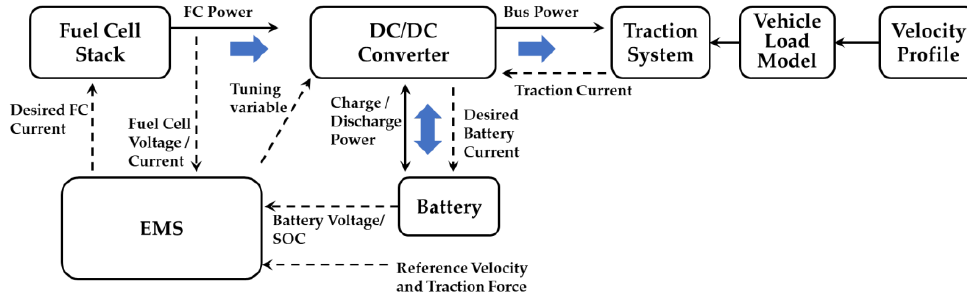
Figure 1. Diagram of fuel cell/battery energy system.